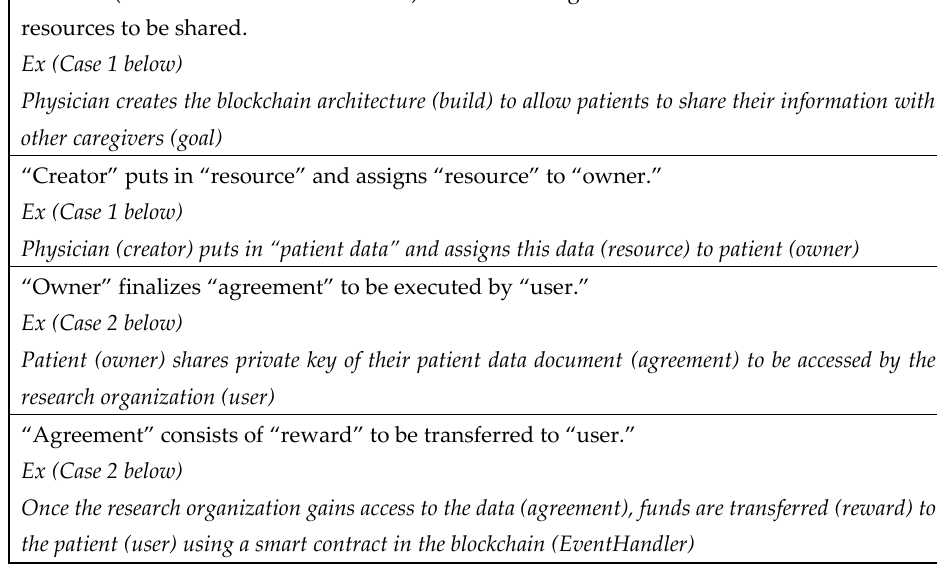
Figure 2. Narrative of the conceptual model to align goals and share resources. Table 1. Constructs as they are applied to each